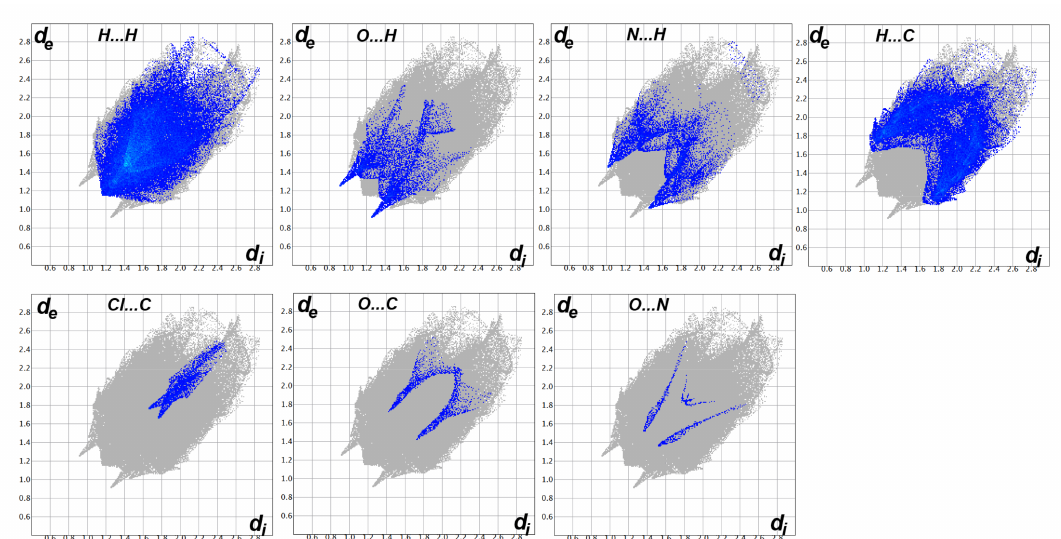
Figure 6. Decomposed fingerprint plots for the important interactions in 4